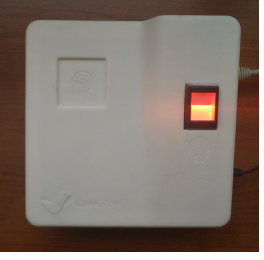
Figure 11. Top view of the second prototype.